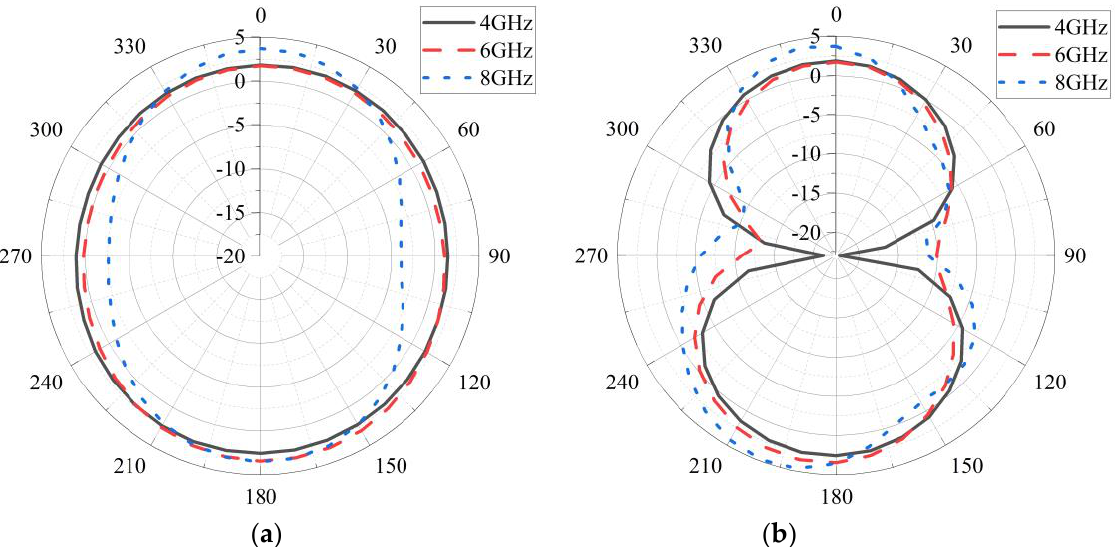
Figure 5. Simulated radiation pattern of textile antenna at 4 GHz, 6 GHz, and 8 GHz in the ( a ) xoz-plane and ( b ) yoz-plane.